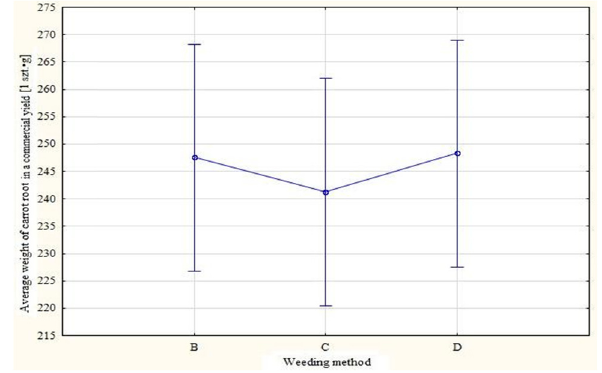
Figure 14: The expected marginal averages for 0.95 con fi dence intervals for the average weight of carrot root in various weeding methods in 2018 ( source: own work ) .